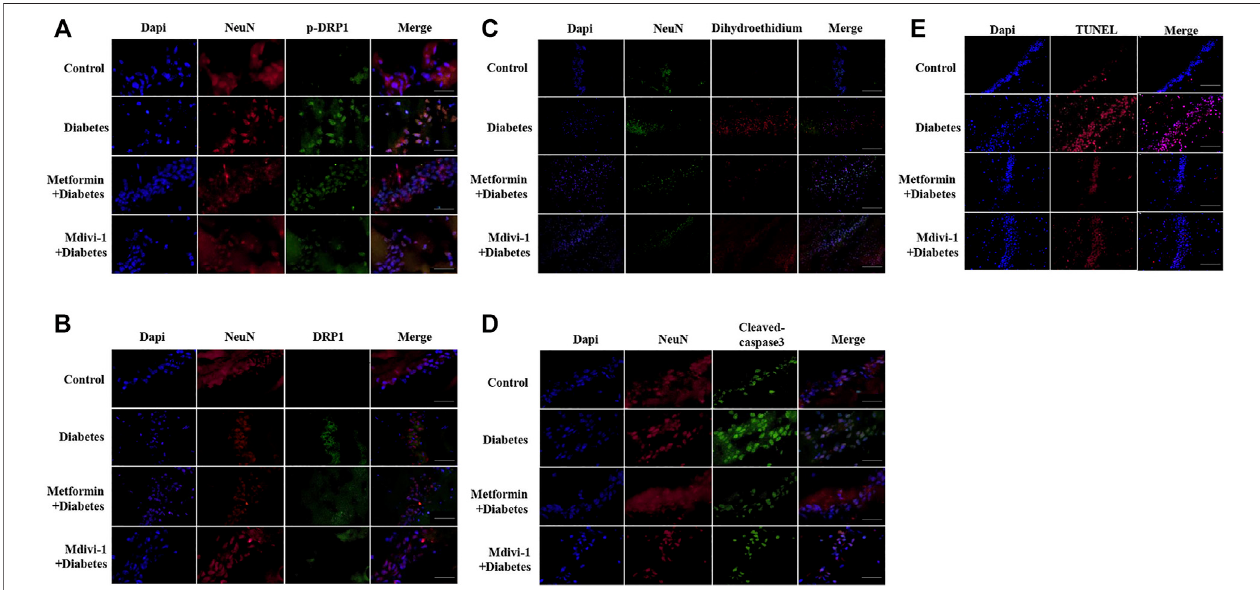
FIGURE 6 | Metformin protects against cognitive dysfunction in diabetes by inhibiting DRP1 phosphorylation in the hippocampus. Presences of phosphorylated DRP1 (A) (400 ×) and total DRP1 protein (B) (400 ×) in hippocampal neurons. (C) Presences of oxidative products in hippocampal neurons (200×). (D) Presences of cleaved caspase-3 in hippocampal neurons (400×). (E) Presences of TUNEL signals in hippocampal neurons (200×) DAPI labeled the nuclei (blue), and TUNEL was stained in red (Fluor